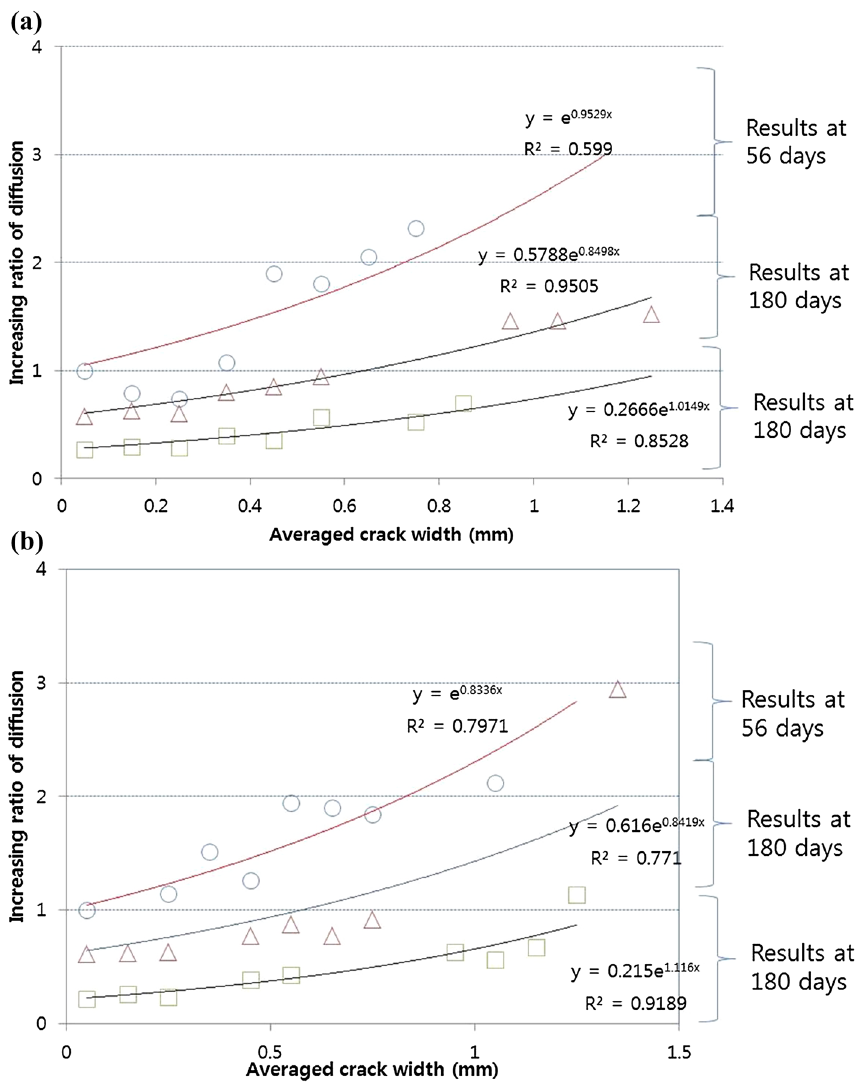
Fig. 6 Diffusion normalization with time and crack width. a Result normalization of N grade. b Result normalization of H grade.